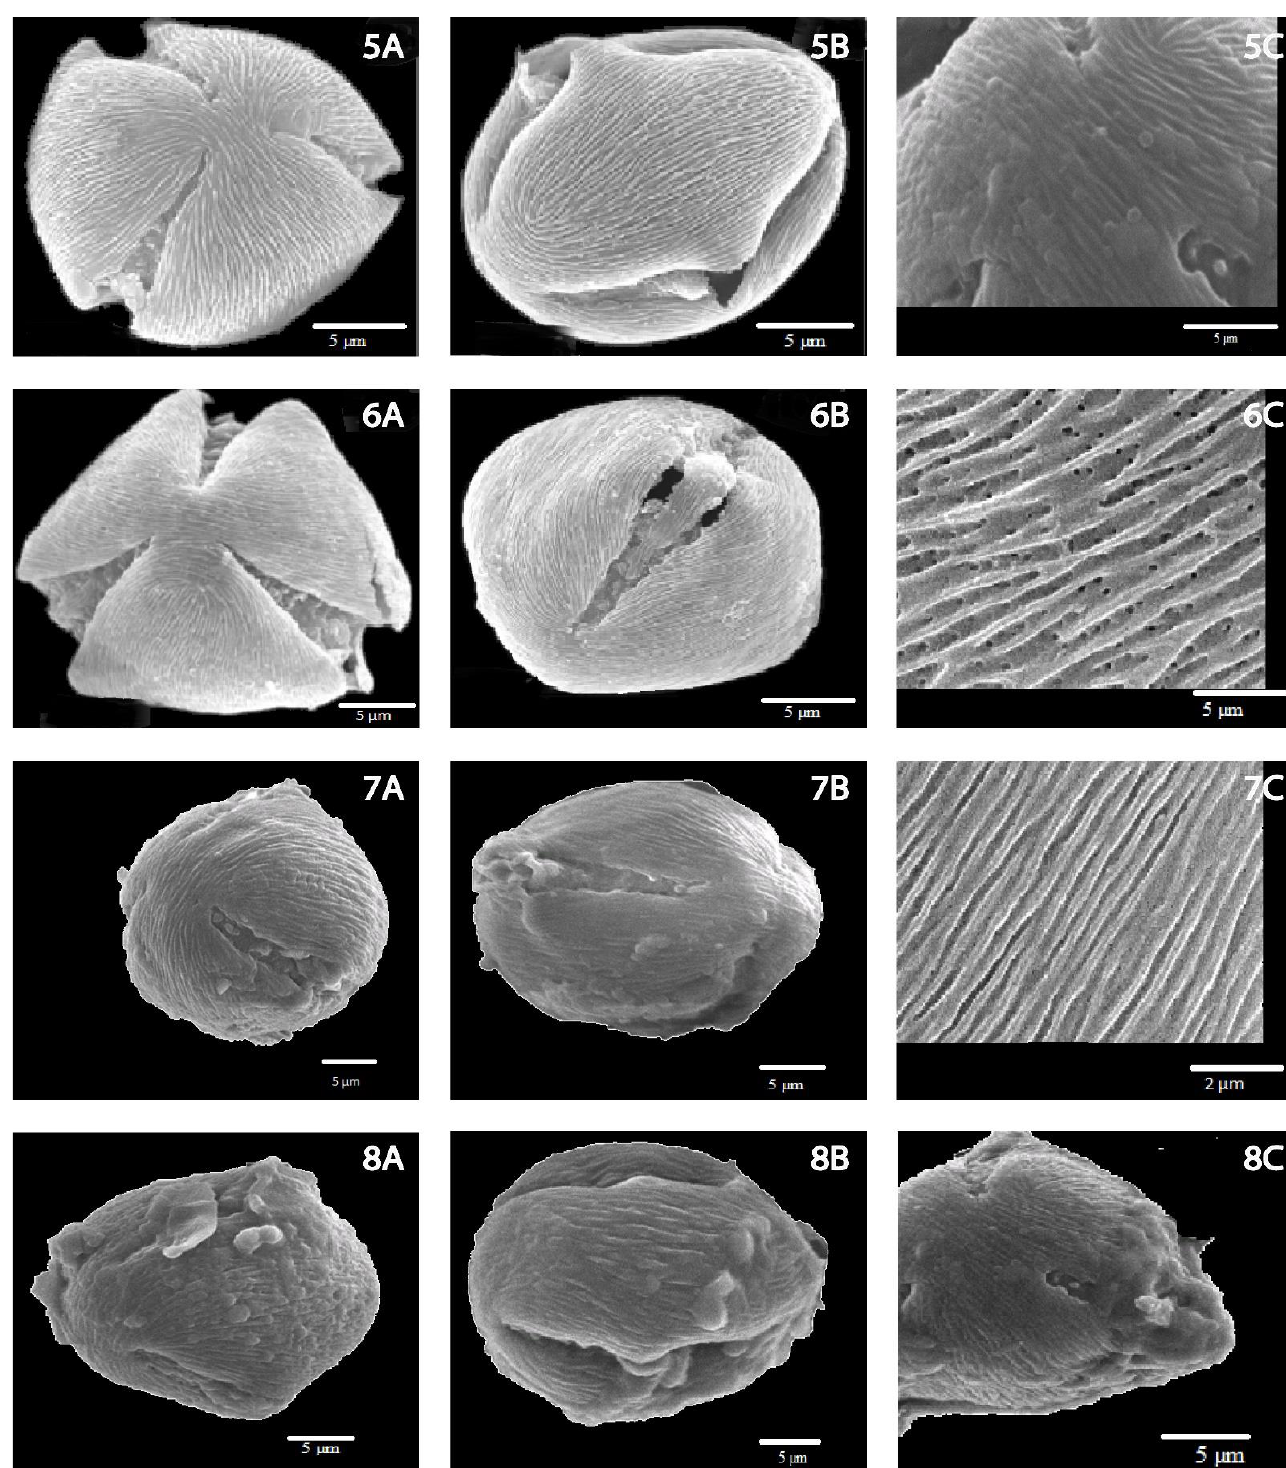
Figure 3. ( A , B ). Different shapes of pollen ( C ). surface 16785-( 5A – 6C ) R. mairei , 16639-( 7A – 8C ) R. omeiensis .